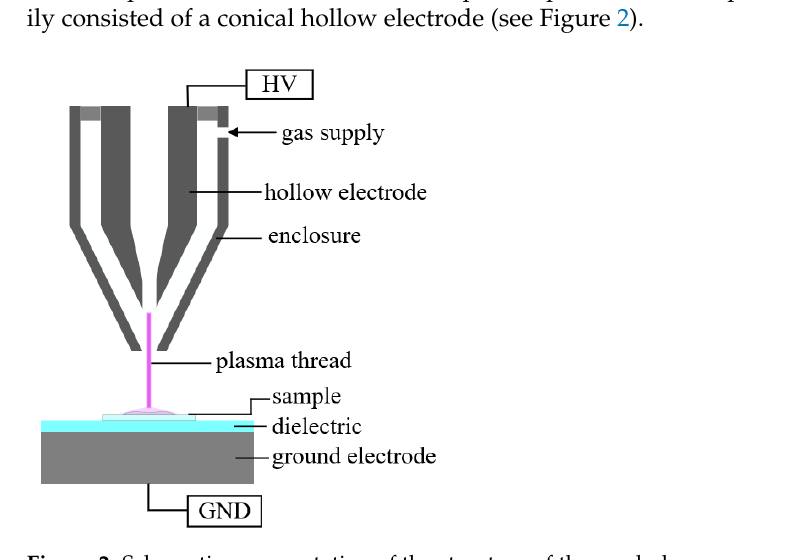
Figure 2. Schematic representation of the structure of the used plasma source. At a distance of approx. 15 mm to the tip of the hollow electrode, a glass plate was positioned which functioned as a dielectric on the counter electrode. A mixture of 80 % argon and 20 % synthetic air, adjusted with flow meters (Krohne, Duisburg, Germany, type DK800), was used as the working gas. A pulsed alternating high voltage was applied to the hollow electrode, as a result of which a stationary, thread-like direct plasma was ignited between the hollow electrode and the counter-electrode. This plasma thread consists